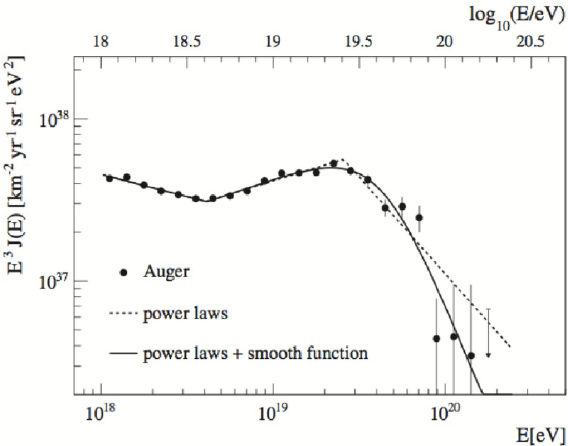
Figure 1: The combined Auger energy spectrum. Only statistical uncertainties are shown. The system- atic uncertainty on the energy scale is 22%.